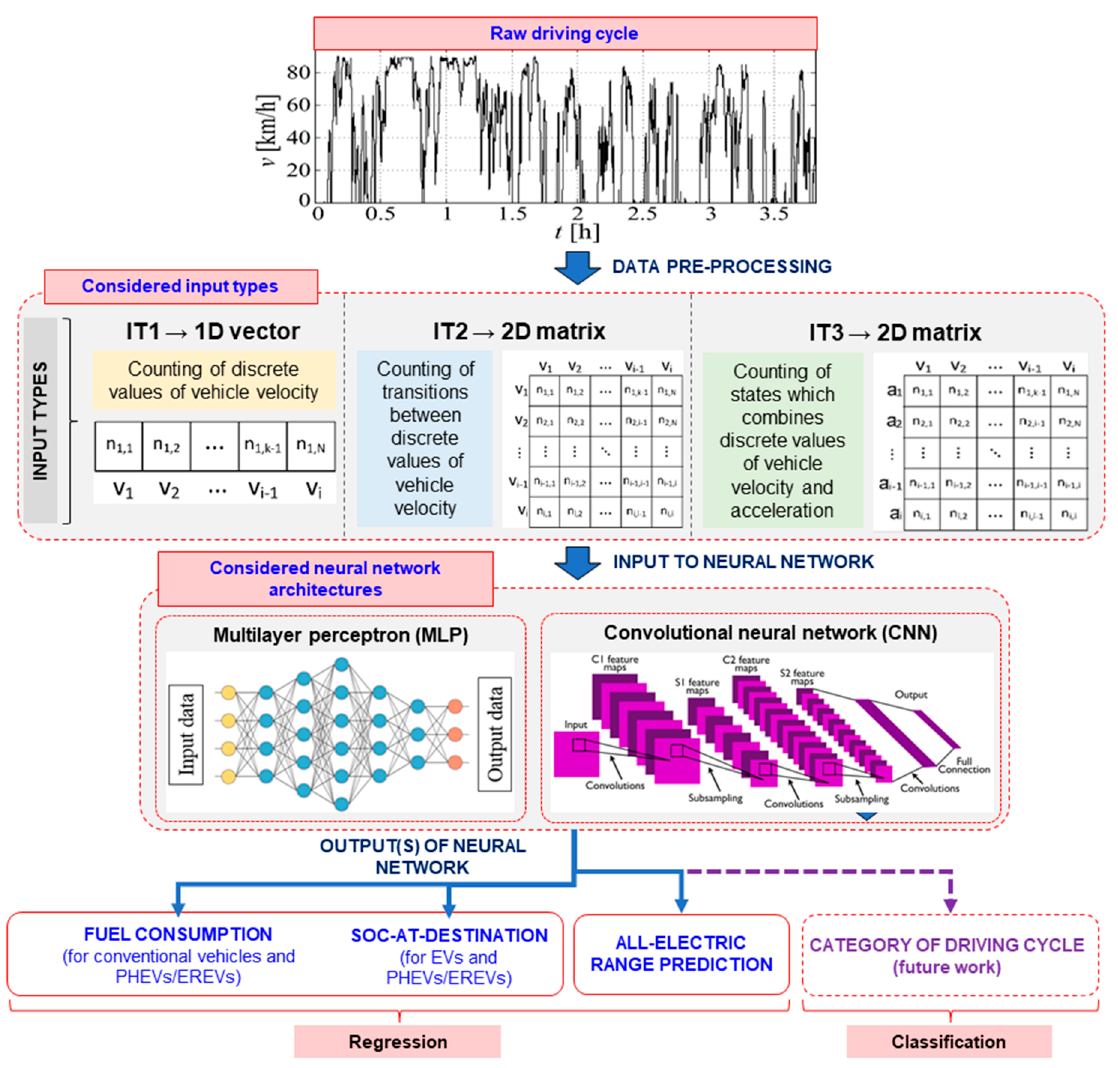
Figure 1. Illustration of the vehicle energy demand modeling procedure including definition of NN input type formats (i.e., IT1, IT2, IT3) and NN architectures (i.e., MLP, CNN).